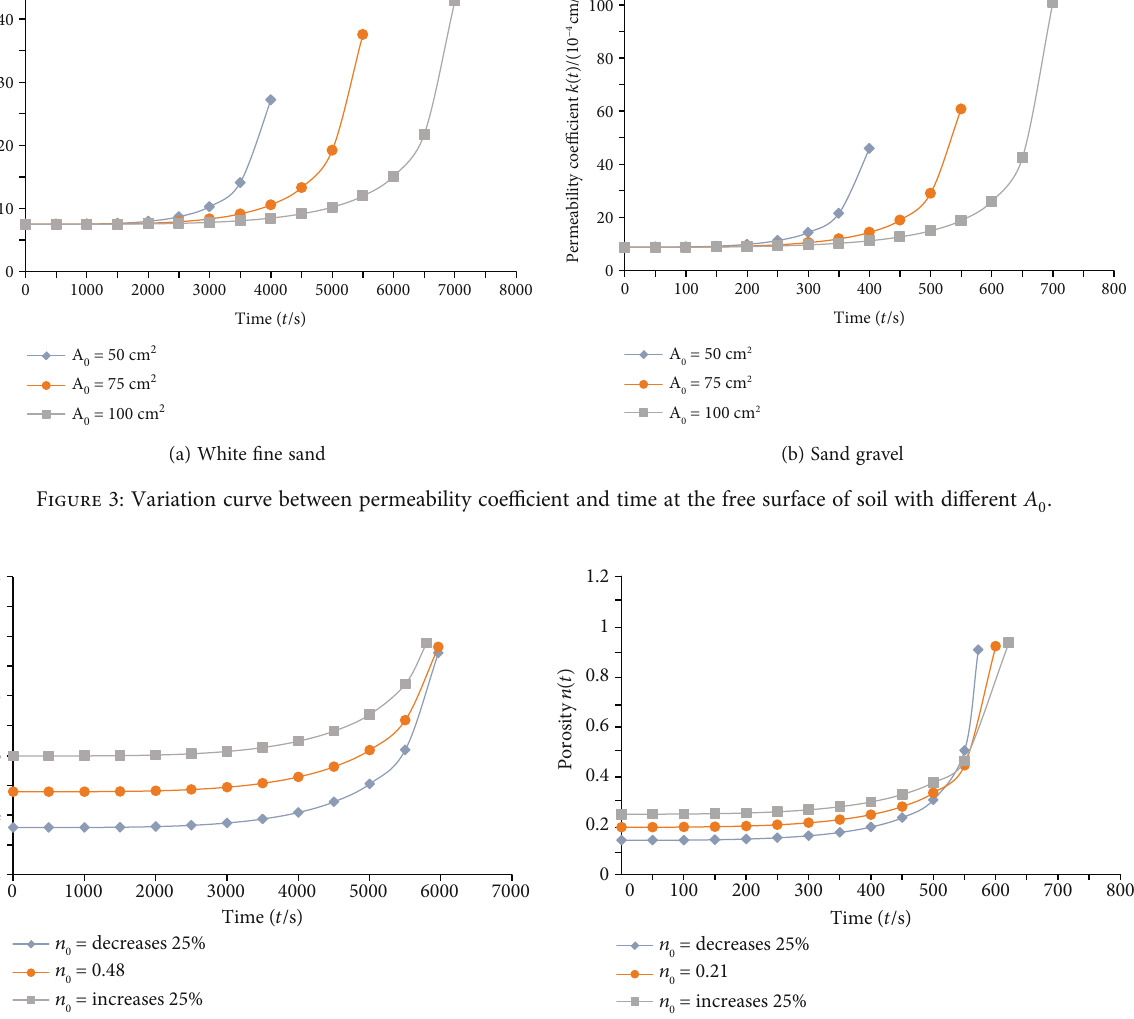
Figure 4: Variation curve between porosity and time at the free surface of soil with di ff erent n